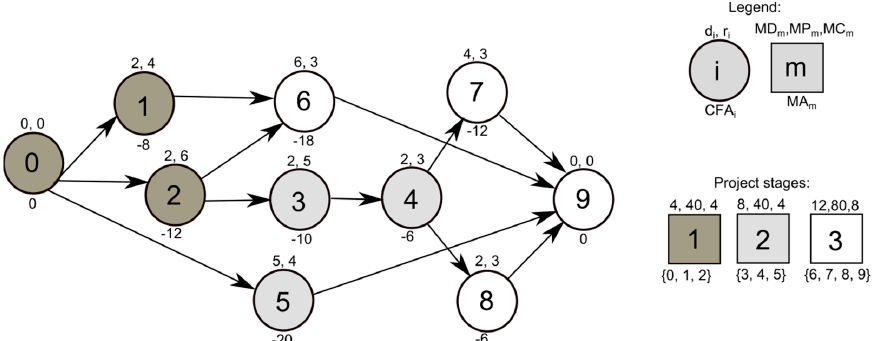
Figure 3. Project in AON representation with defined stages.